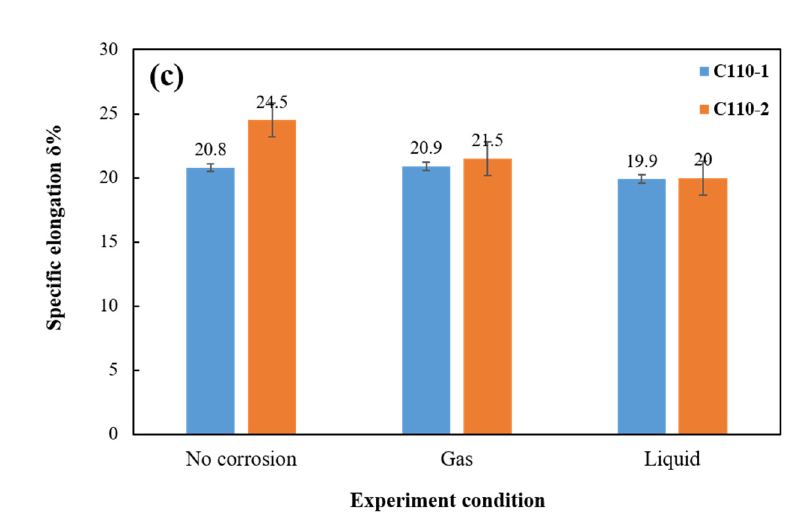
Figure 16. Comparison of mechanical properties: ( a ) Yield strength; ( b ) Tensile strength; ( c ) Specific elongation.